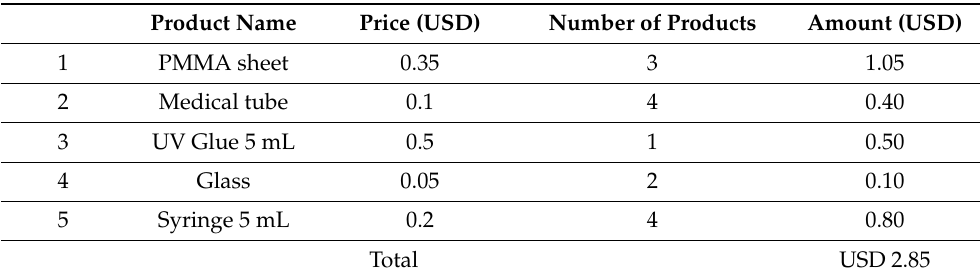
Table 1. Price list for each component of the device and the total value of the microfluidic system. The price list does not include the processing